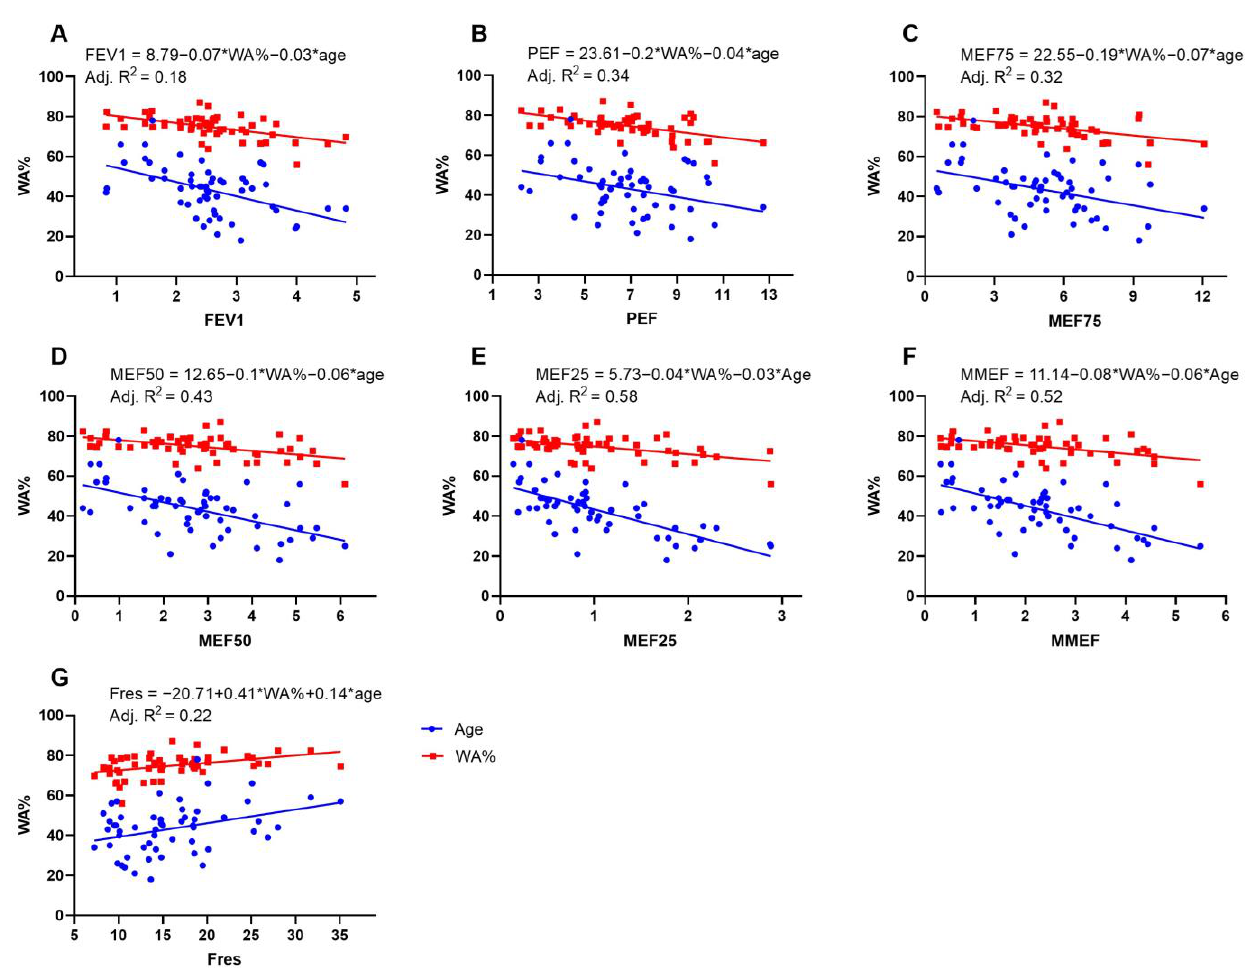
Figure 3. Multivariate linear regression. The blue and red symbols represent age and WA%, respec- tively. ( A ) FEV1, forced expiratory volume in one second; ( B ) PEF, peak expiratory flow; ( C ) MEF75, maximal expiratory flow at 75% of the FVC; ( D ) MEF50, maximal expiratory flow at 50% of the FVC; ( E ) MEF25, maximal expiratory flow at 25% of the FVC; ( F ) MMEF, maximal mid-expiratory flow; ( G ) Fres, resonance frequency.